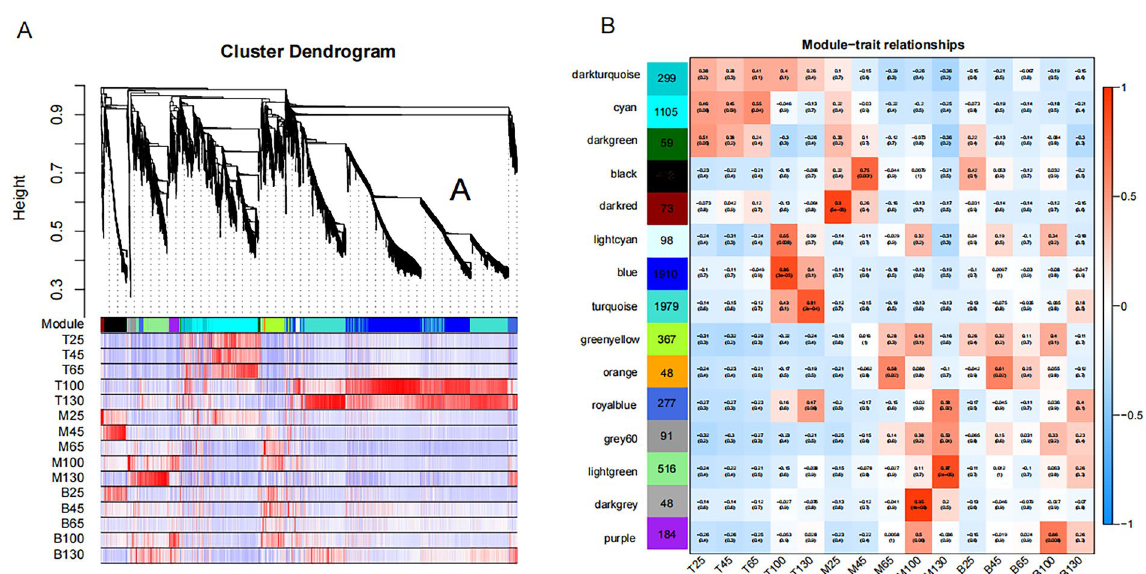
Figure 2. Differentially expressed gene analysis. ( A ) UpSet Plot for DEGs between the growing antler tip and ossification antler tip. 1717 DEGs were shared by the 6 groups. ( B ) Heat map of 1717 differentially expressed genes at growth and ossification stages. The UpSet Plot and gene expression heat map were generated using TBtools software (version 1.082, https:// github. com/ CJ- Chen/ TBtoo ls).